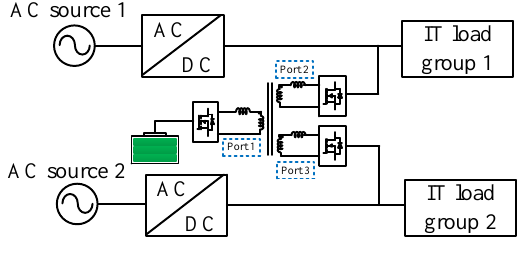
Figure 16. TAB converter in power distribution for data center